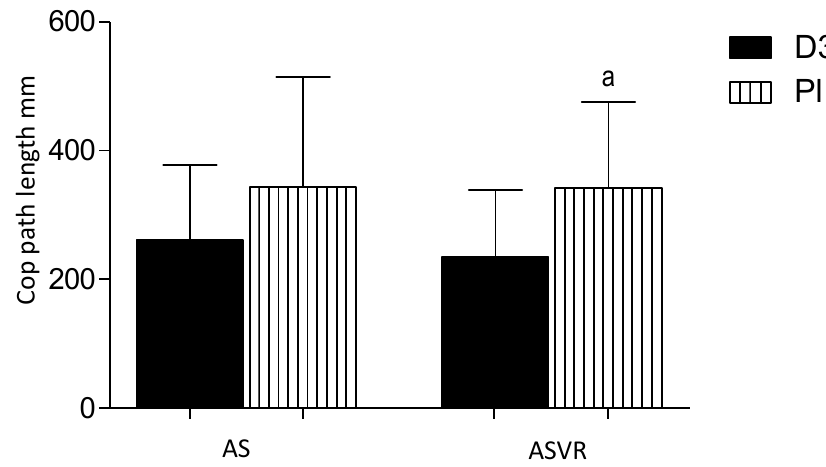
Figure 8. Vitamin D supplementation decreased the center of pressure (CoP) path length (mm) in patients after anterior cervical interbody fusion surgery. Columns, mean and bars, standard deviations (SDs). a, p < 0.05, significantly different compared with ASVR D3 by one-way ANOVA. The average pressure distribution of the left and right feet expressed in body weight (%) was also evaluated in the patients; however, the changes were not significant.